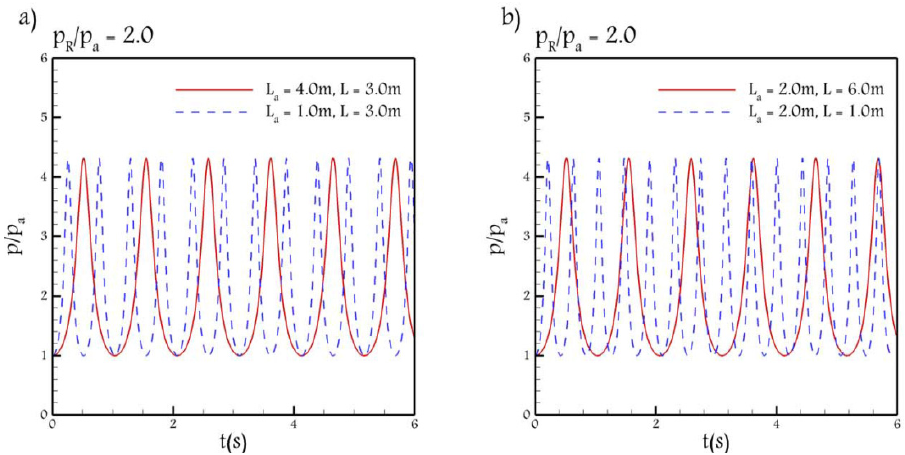
) distribution vs. the time, calculated a ) of 2.0, and /p R a